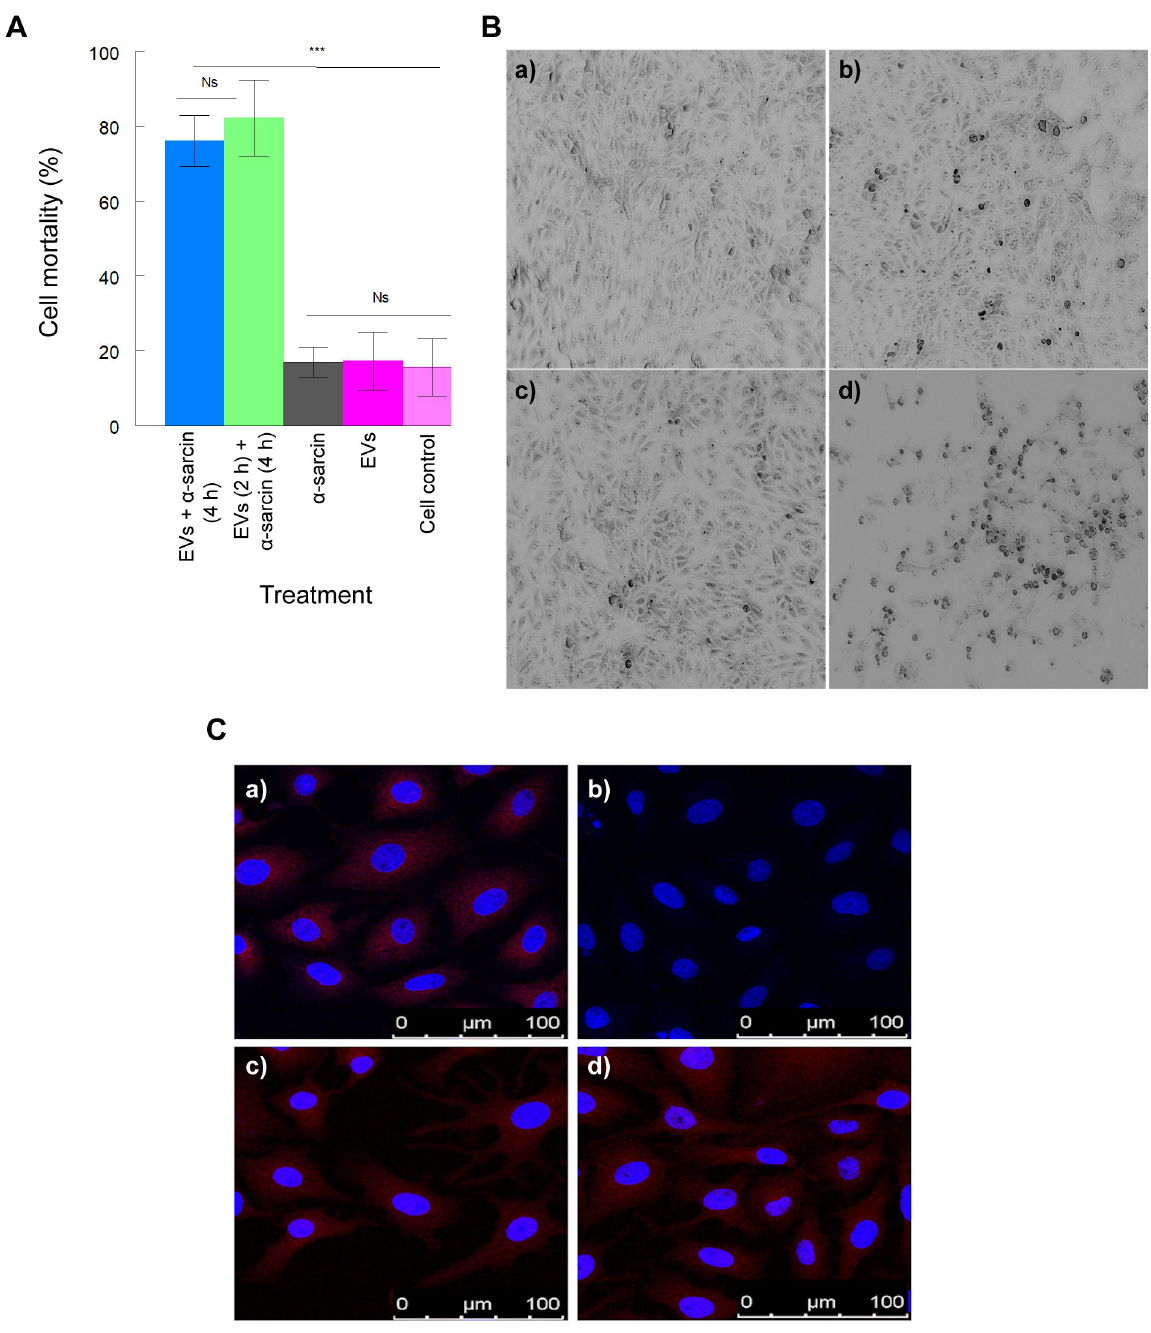
Fig 2. Cell permeabilization of Vero and HL-1 cells by EVs of T . cruzi Pan4. A cell-viability assay to evaluate the entry of α -sarcin in Vero cells after the incubation with EVs of T . cruzi using MTT was performed (A). Cells were incubated with T . cruzi EVs for 2 h, washed, and then incubated with the toxin α -sarcin for 4 h. The MTT cell viability assay was performed at 24 h of the incubation with EVs, following the manufacturer’s instructions. Cells treated only with α -sarcin, EVs and untreated cells were used as controls. The cell monolayers incubated with EVs, α -sarcin or both are shown in B; a) control Vero cells; b) Vero cells treated with EVs for 2 h; c) cells treated with α -sarcin (20 μ M) for 4 h; d) cells treated with EVs for 2 h and then treated with α -sarcin (20 μ M) for 4 h. The cell cultures were examined at 24 h of the treatment. Low magnification fields were taken in order to show the overall effect of the different treatments on the cell culture. Permeabilization was also evaluated in HL-1 mouse cardiomyocyte cells (C); a) HL-1 mouse cardiomyocyte cells incubated with T . cruzi EVs for 2 h, fixed in a solution of paraformaldehyde/glutaraldehyde for 1 h and incubated with the anti- β 2-adrenergic receptor antibody (anti β 2R); b) HL-1 mouse cardiomyocyte cells not incubated with the EVs, fixed with paraformaldehyde/glutaraldehyde for 1 h and incubated with the anti- β 2R (control); c) HL-1 mouse cardiomyocyte cells not incubated with the EVs, fixed with paraformaldehyde/glutaraldehyde for 1 h and permeabilized in a solution of NP-40 in